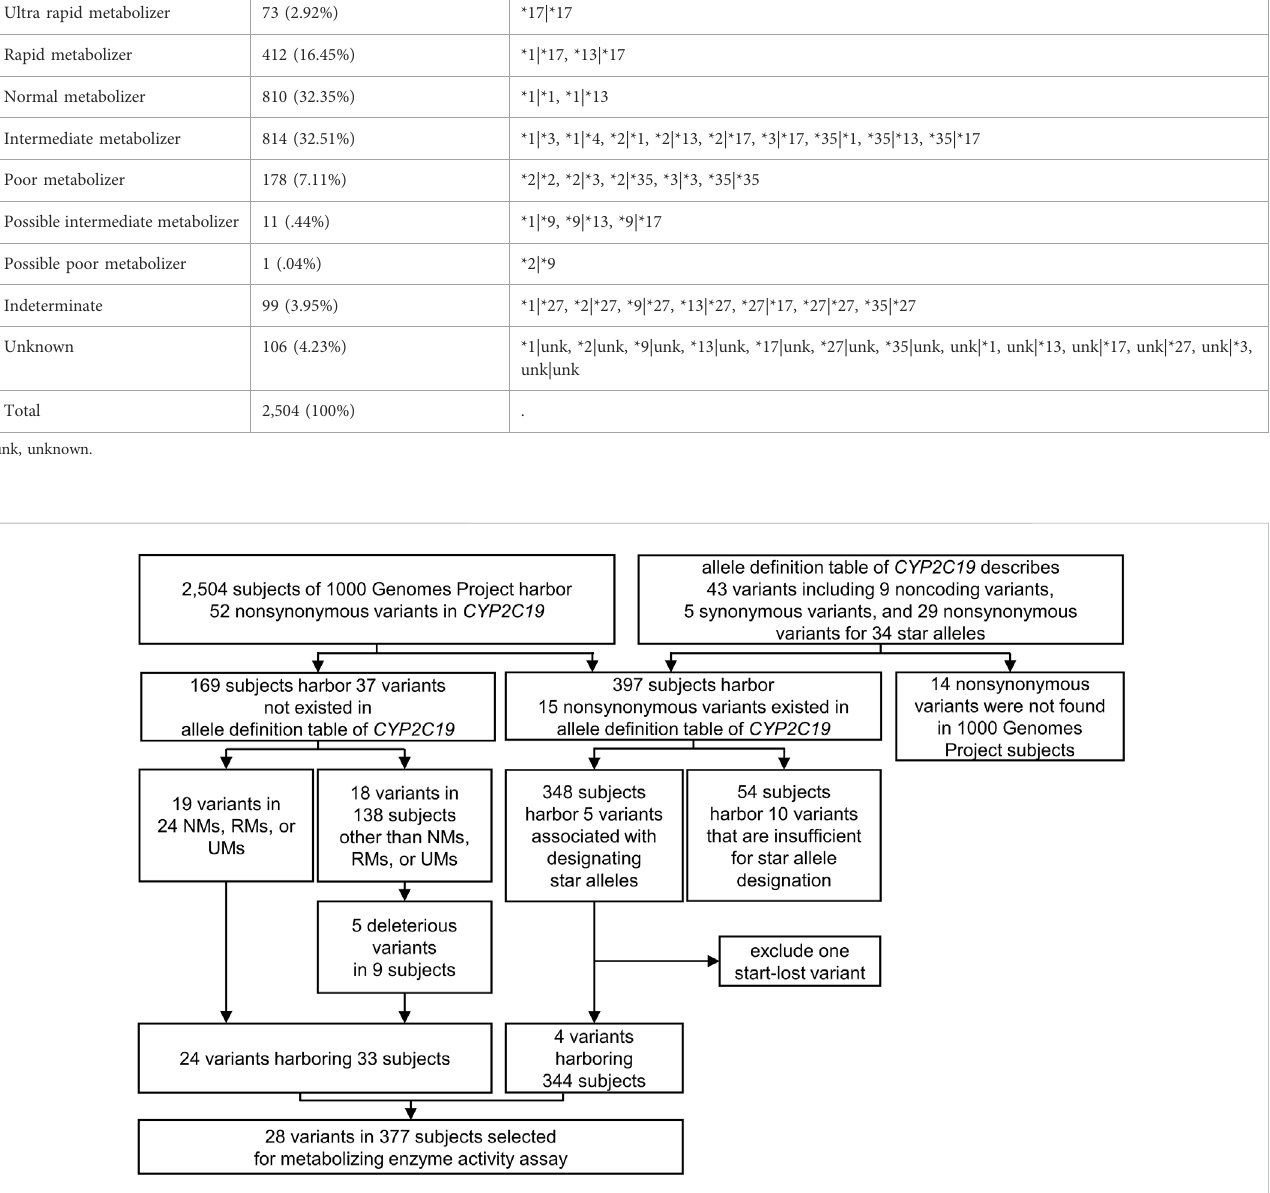
FIGURE 1 The variant selecting process for metabolizing enzyme activity assay. All the variants in the CYP2C19 region ( chr10:96522438-96615304 , GRCh37) of 2,504 subjects in the 1000 Genomes Project were considered to select metabolizing capability assay candidates. 24 non-synonymous variants not exist in allele de fi nition table and four non-synonymous variants included in the result of CYP2C19 phenotype classi fi cation were selected. UM, Ultra rapid metabolizer; RM, Rapid metabolizer; NM, Normal